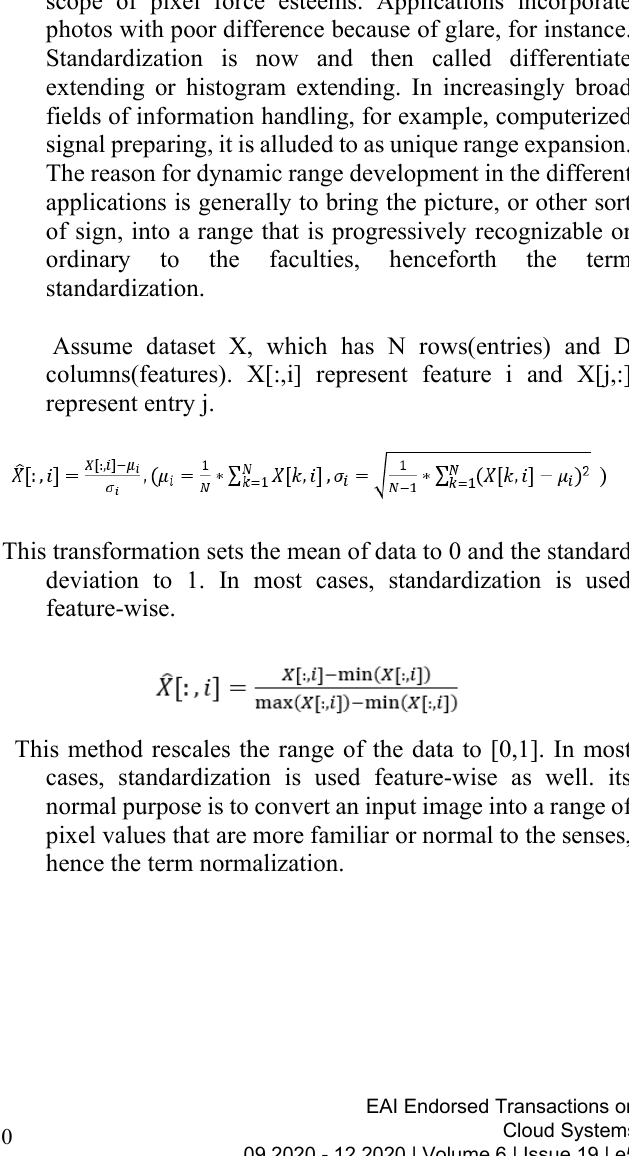
scope of pixel force esteems. Applications